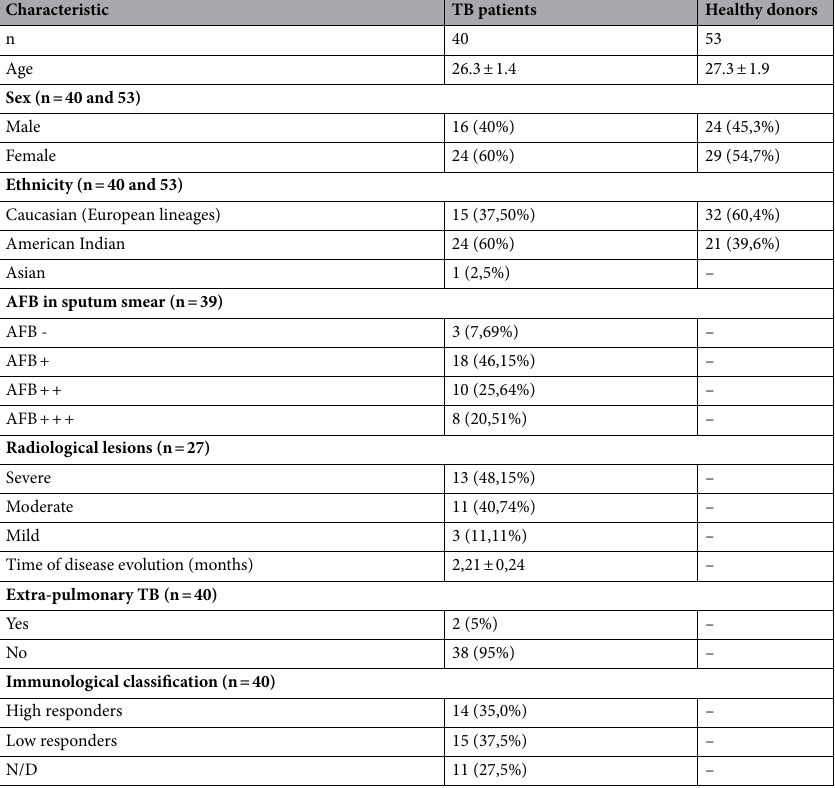
Table 1. Demographic and clinical parameters of TB patients and healthy donors. Acid-Fast Bacilli (AFB) in sputum smear represent: AFB-, 0 bacilli count; AFB + , 1–9 bacilli/100 fields; AFB + + , 1–9 bacilli/10 fields; AFB + + + , 1–9 bacilli/field. Radiological lesions: "mild" corresponds to patients with a single lobe involved and without visible cavities; "moderate" relates to patients presenting unilateral involvement of two or more lobes with cavities, if present, reaching a total diameter no greater than 4 cm; "severe" corresponds to bilateral disease with massive affectation and multiple cavities. Clinical symptoms analyzed in TB patients previous to hospital admission to establish the time (months) of disease evolution were: weight loss, night sweats, symptoms of malaise or weakness, persistent fever, presence of cough, history of shortness of breath, and hemoptysis. Continuous data are expressed as mean ± SEM, and categorical data are expressed as number